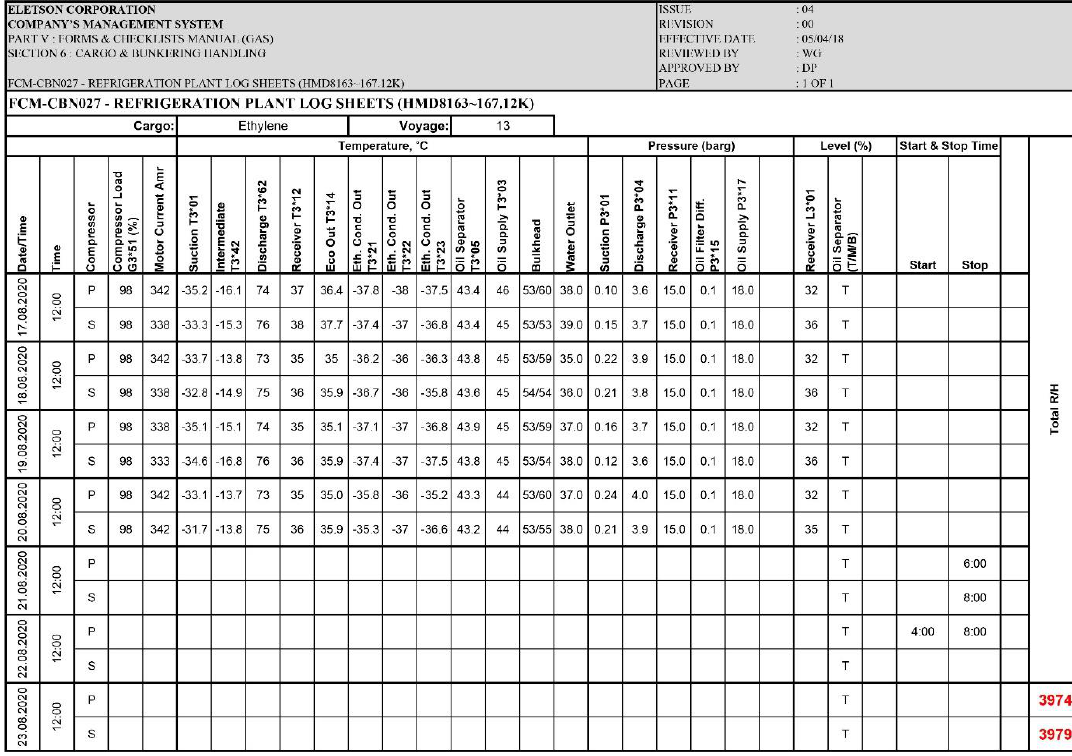
Figure 3. Real-time monitoring of the cargo operations (refrigeration plant log sheet).